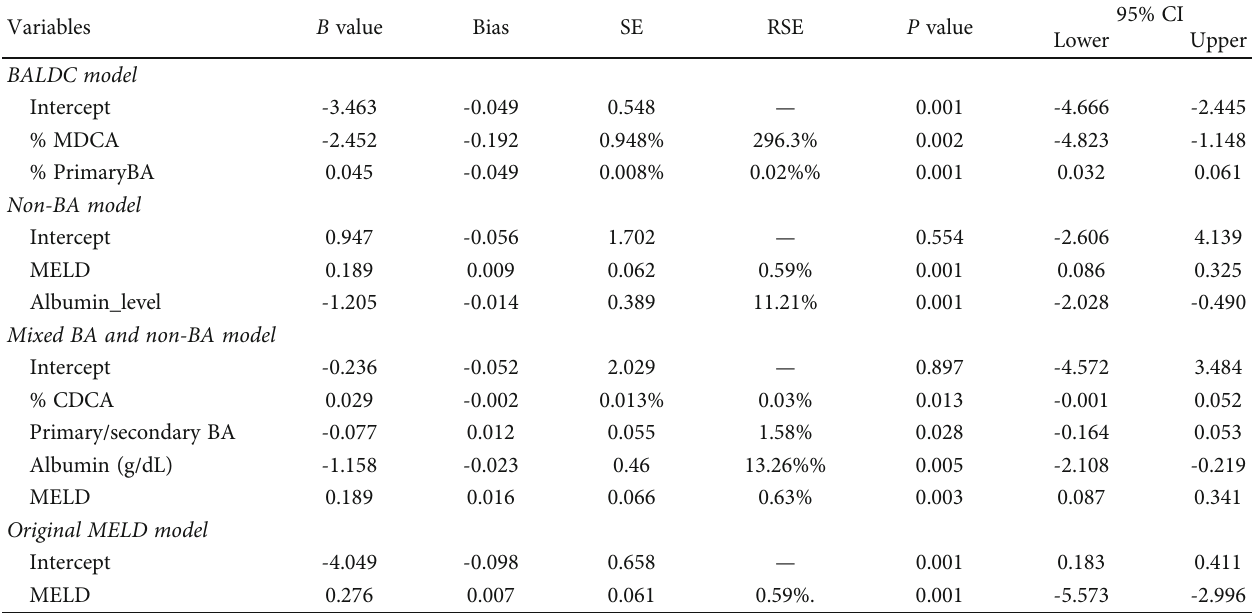
Table 7: Bootstrapping validation for ascites predication